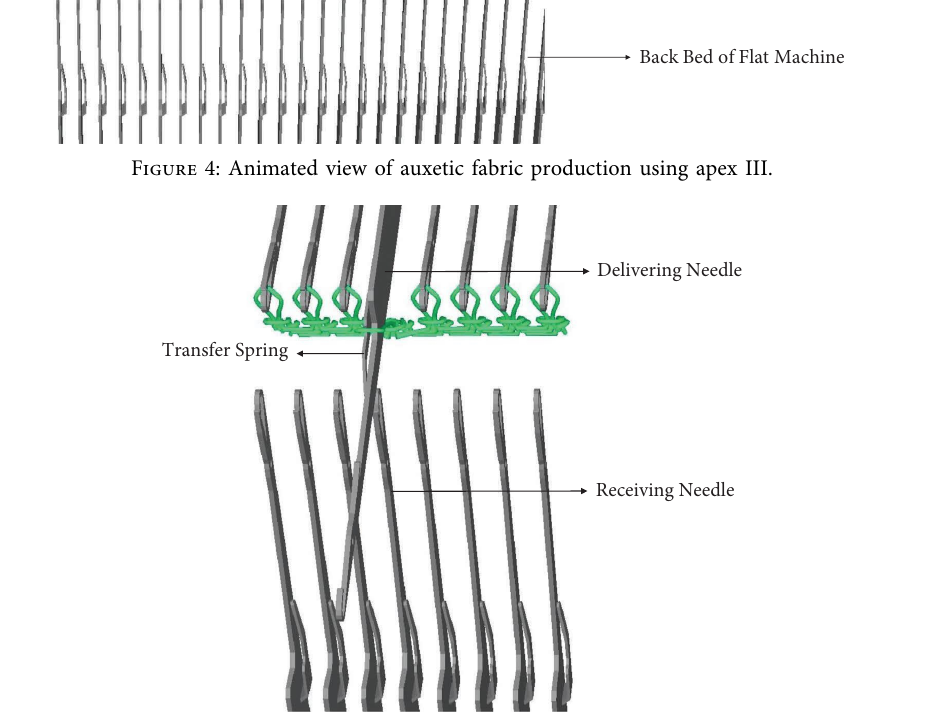
Figure 5: Animated view of delivering needlework during stitch transfer process using the apex III design